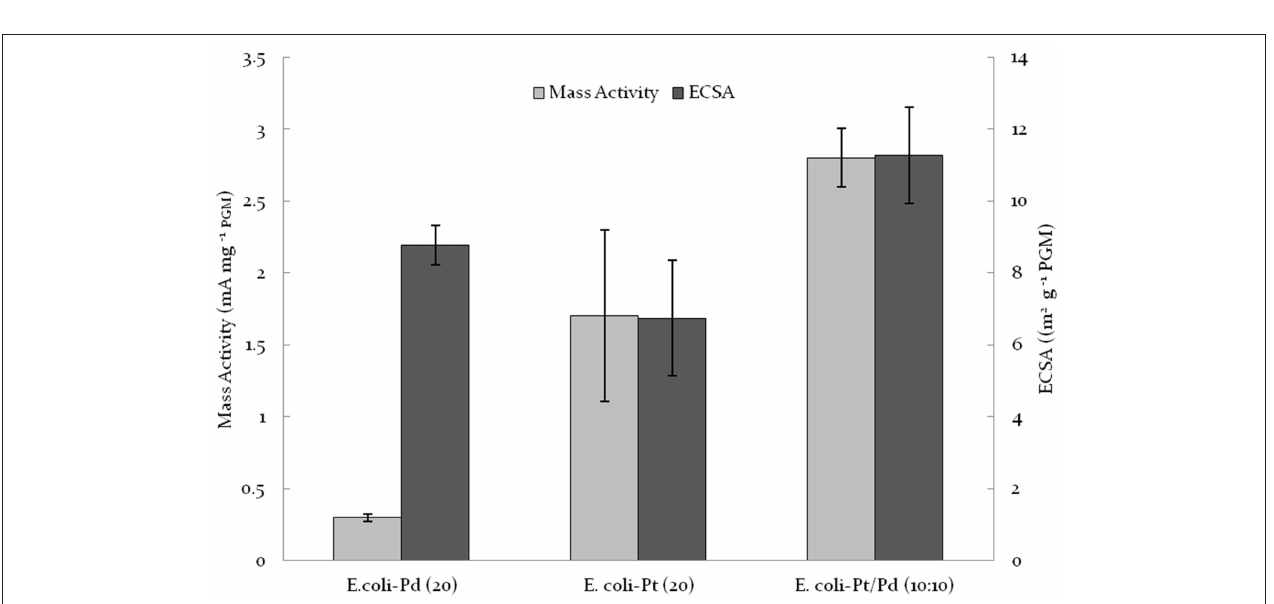
FIGURE 7 | Comparison of E. coli -Pt/Pd (10%:10%) mass activities and ECSA against E. coli -Pd (20%) and E. coli -Pt (20%).